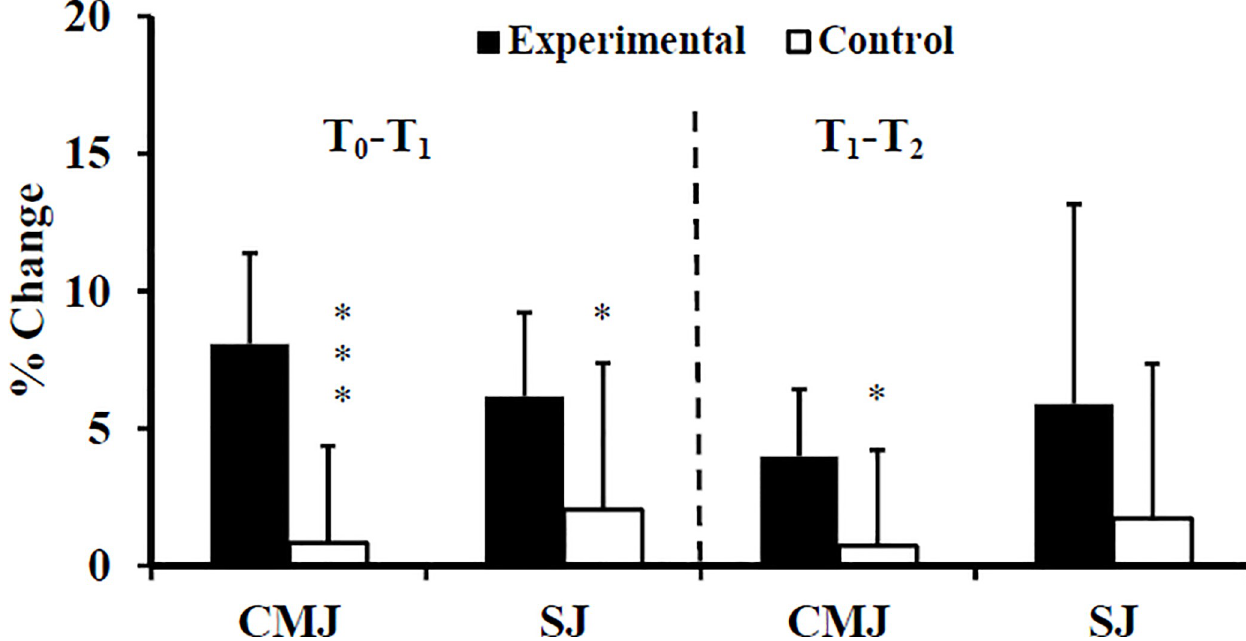
Fig 4. Percentage changes of vertical jump height at T 1 , and T 2 for Experimental (E) and Control (C) groups. T 0 : before training; T 1 : after 10 weeks of resistance training; T 2 : after 2 weeks of tapering; CMJ: Counter-movement Jump; SJ: Squat Jump; � : ANOVA group x time interaction significantly different between E and C at the level of p < 0.05; ��� : ANOVA group x time interaction significantly different between E and C at the level of p < 0.001.